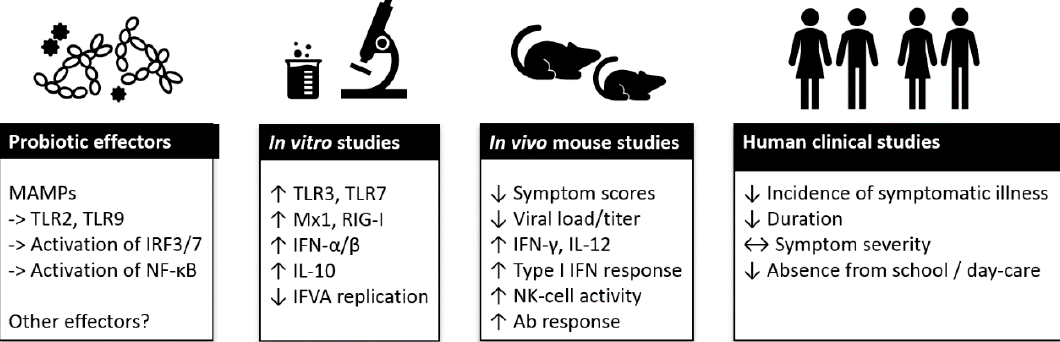
Figure 1. Summary of probiotic effector mechanisms and clinical evidence on viral respiratory tract